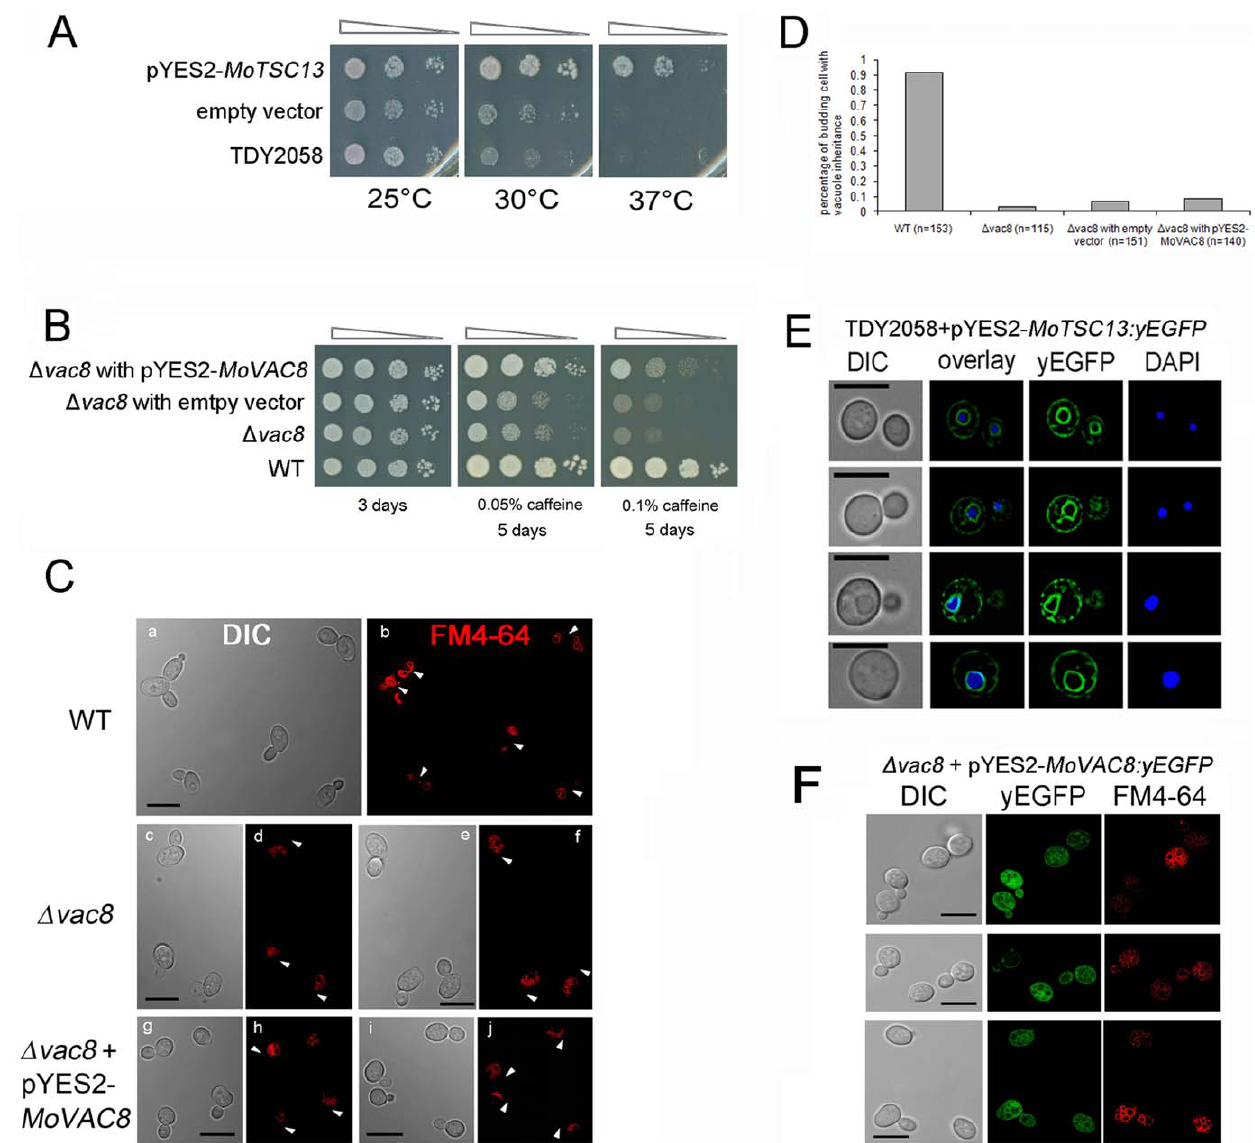
Figure 4. MoTSC13 is functionally equivalent to S.cerevisiaeTSC13 , while MoVAC8 only partially substitutes for VAC8 . ( A ) MoTSC13 complemented the temperature-sensitive lethality of the yeast strain TDY2058 (double mutant tsc13-1 D elo ). Yeast tsc13-1 D elo mutants were transformed either with empty vector or a plasmid expressing MoTSC13 cDNA under control of the galactose-inducible GAL1 promoter. Cells were grown in YPDA overnight, normalized to and subjected to 10-fold serial dilutions, spotted onto SD + Gal plates and incubated at 26 u C, 30 u C or 37 u C for 3 days prior to photographing. The experiments were carried out in triplicate, examining two independent yeast transformants. ( B ) MoVAC8 complemented the caffeine sensitivity of yeast strain BY4741 vac8 D ::KANMX4 . Yeast vac8 D ::KANMX4 mutants were transformed with empty vector or a plasmid expressing MoVAC8 cDNA under the control of the GAL1 promoter. Cells were grown in YPDA overnight, normalized and subjected to 10- fold serial dilutions, spotted onto SD + Gal plates containing either 0.05% or 0.1% caffeine, and incubated at 26 u C for the indicated period of time. The experiments were carried out in triplicate, examining two independent yeast transformants. ( C ) MoVAC8 does not complement vacuole morphology and vacuole inheritance defects of yeast mutant vac8 D ::KANMX4 . FM4–64 was used to stain cells of S. cerevisiae , vac8 D ::KANMX4 and vac8 D ::KANMX4 strain, expressing MoVAC8 by pulse-chase labelling. Arrows indicates presence (b) or absence (d, f, h, j) of segregating vacuoles. ( D ) MoVAC8 failed to complement vacuole inheritance defects of yeast mutant vac8 D ::KANMX4 during budding. Pulse-chase labelled S. cerevisiae cells by FM4–64 were counted for the proportion of daughter cells carrying vacuoles inherited from the mother cell during budding. (N indicates the total number of cells counted). ( E ) MoTSC13p localises to the perinuclear and peripheral ER membrane in S. cerevisiae . yEGFP tagged MoTSC13p was expressed in yeast strain TDY2058 under control of the GAL1 promoter in plasmid pYES2. Cells were stained with DAPI to visualise nuclei. ( F ) MoVAC8p failed to accumulate at the vacuolar membrane in S. cerevisiae . yEGFP tagged MoVAC8p was expressed in yeast strain vac8 D ::KANMX4 under control of GAL1p promoter in plasmid pYES2. doi:10.1371/journal.pone.0033270.g004 We also introduced MoVAC8 : GFP gene fusion into the H1 : RFP - carried out with the MoVAC8 : GFP , H1 : RFP strain to observe expressing strain of M. oryzae to investigate formation of putative appressorium development (Figure 6 A). The large vacuole in the nuclear-vacuolar (NV) junctions. A time-course experiment was conidium occupied the majority of the conidial cell volume and,